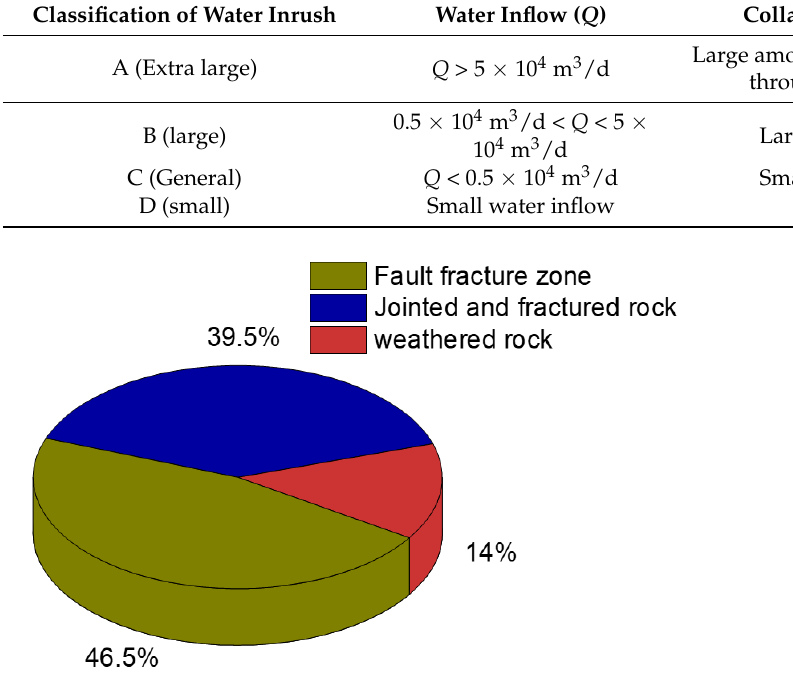
Figure 8. Proportion of water inrush from each unfavorable geology type in tunnels.